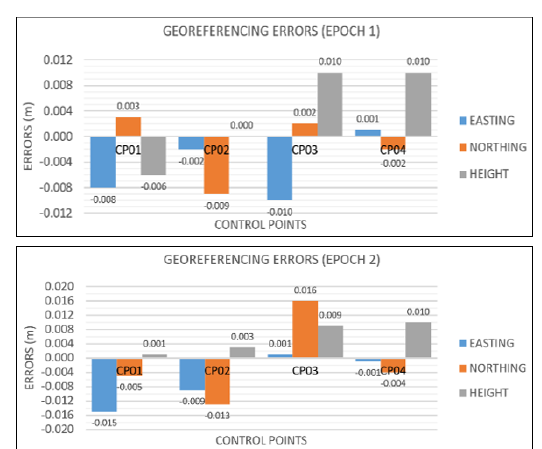
Figure 42. The georeferencing errors of epoch 1 and epoch 2 After the evaluation of registration and georeferencing process is carried out, the georeferenced point clouds were compared with all the target scans data observed by Total Station using intersection method. During the target scanning using Topcon GLS-2000 laser scanner, the resolution settings are not required in order to identify the center of the